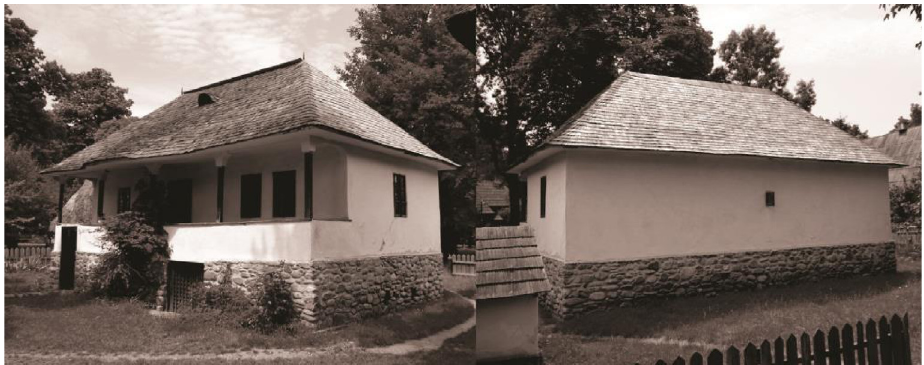
Fig. 2. A traditional house from Stanesti, Arges, XIX-th Century (Center